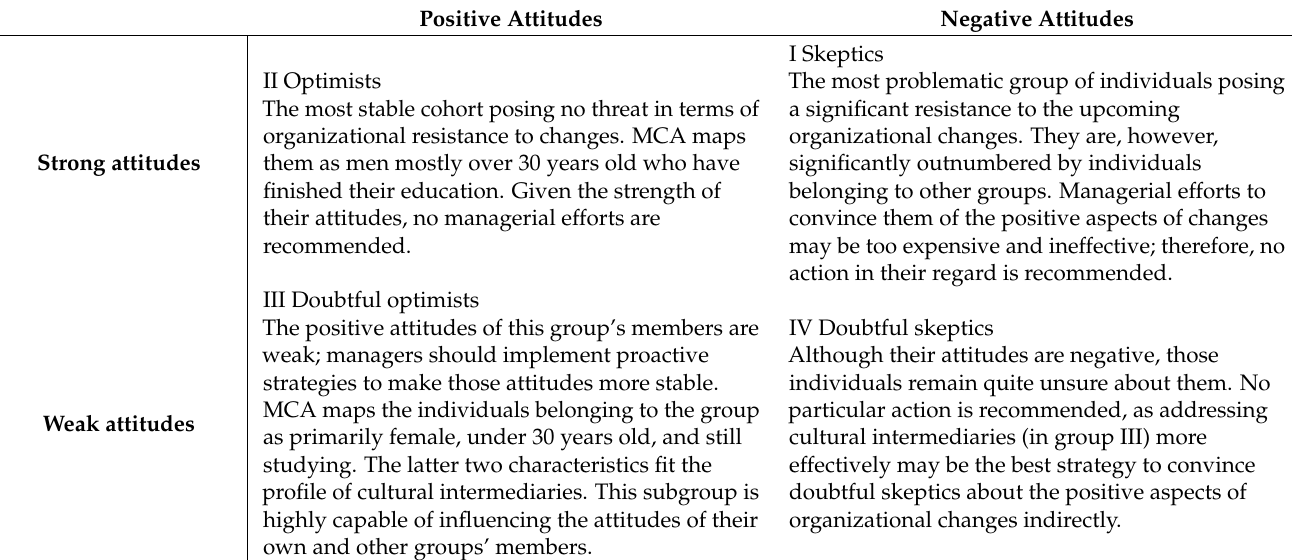
Table 5. Model of intraorganizational response to the AI